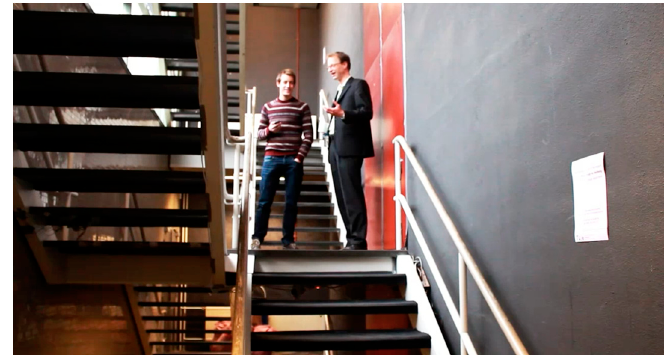
Figure 6. Over the 6 months of the Social Stairs EDL several interviews were held in the EDL with the